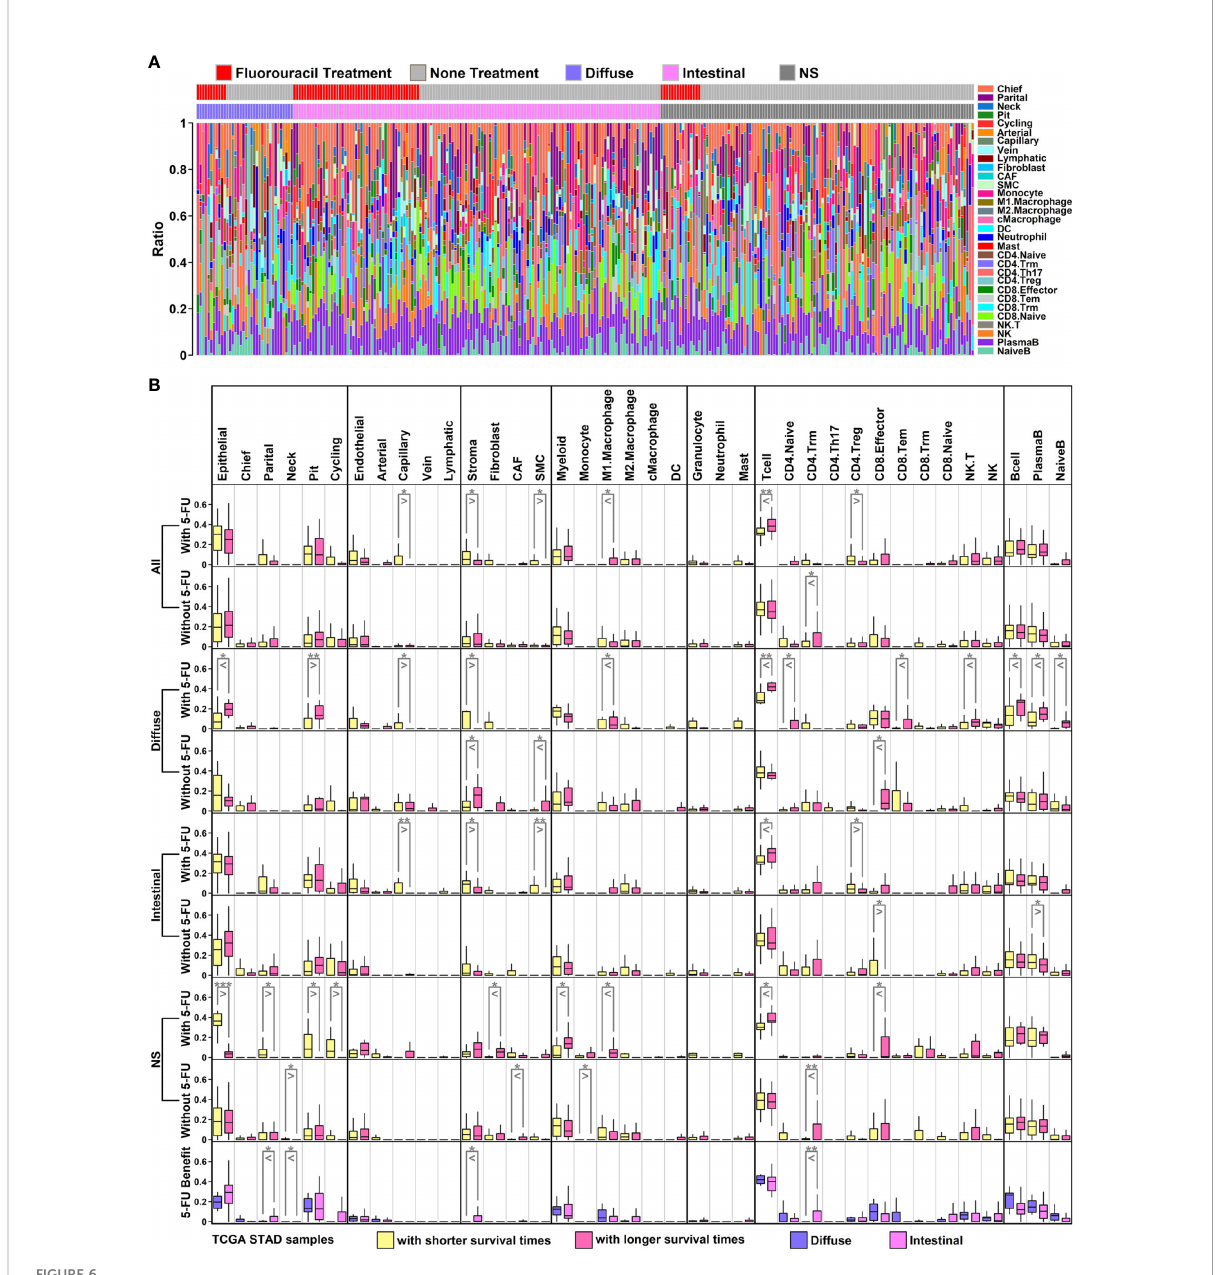
FIGURE 6 Proportion analysis of scRNAseq groups in TCGA STAD samples (A) Bar plot representing proportions of 31 subgroups in each TCGA sample. These data were generated through decomposition analysis; (B) Ratio comparison of 6 main groups/31 subgroups across different types of TCGA samples. All GC samples with 5-FU treatment: row 1; all GC samples without 5-FU treatment: row 2; diffuse samples with 5-FU treatment: row 3; diffuse samples without 5-FU treatment: row 4; intestinal samples with 5-FU treatment: row 5; intestinal samples without 5- FU treatment: row 6; NS samples with 5-FU treatment: row 7; NS samples without 5-FU treatment: row 8; diffuse 5-FU-bene fi t samples vs intestinal 5-FU-bene fi t samples: row 9. (* p < 0.05; ** p < 0.01; *** p < 0.001. Two-tailed